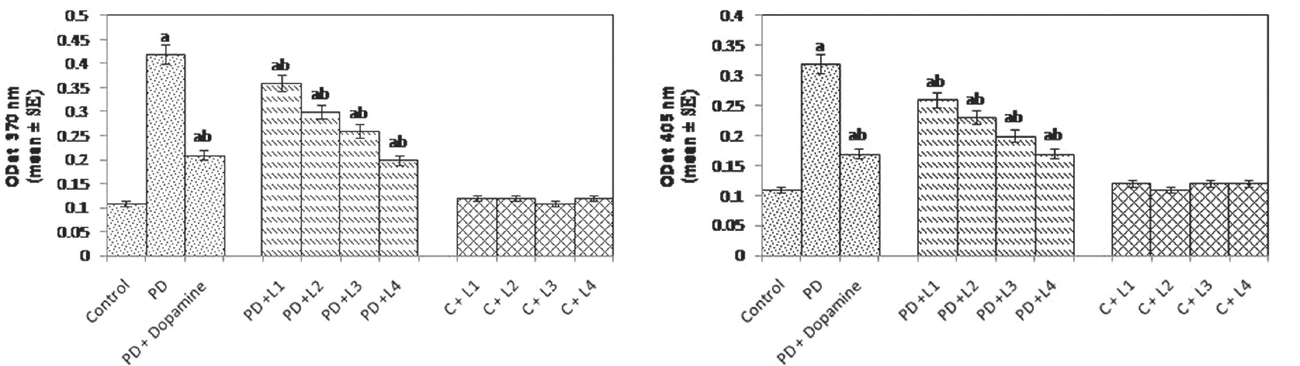
FIGURE 5 - Effect of luteolin on the protein carbonyl content measured in the brains of flies. [L1= 25 µM; L2= 50 µM; L3 = 75 µM; L4= 100 µM; PD = PD flies; Dopamine=10-3 M]. The flies were allowed to feed on the diet supplemented with luteolin for 24 days and then assayed for lipid peroxidation. The values are the mean of 5 assays. [a - significant at p<0.05 compared to control; b - significant at p<0.05 compared to PD flies].